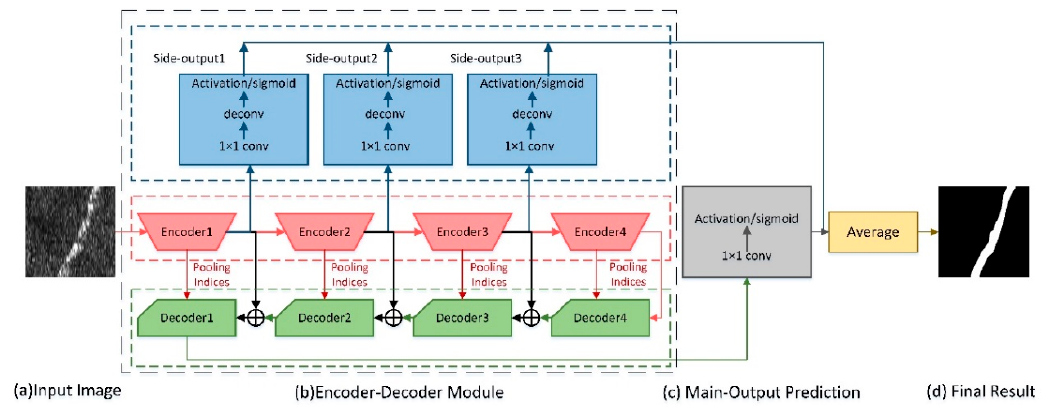
Figure 1. An illustration of the ECNet architecture. Three side-output layers are placed behind encoder1-3. Deep supervision is performed on each side-output layer, conducting the side-outputs to the predictions we expect. Our encoder–decoder module has no fully connected layers in encoder–decoder module. In addition to the inputs of the decoder4, the inputs of the other decoders are the sum of the corresponding encoder outputs and the latest decoder outputs. A decoder performs an up-sampling operation on its input based on the pooling indices the corresponding encoder provide. The feature maps of the final decoder output are given as inputs to a sigmoid classifier to complete the pixel level classification.